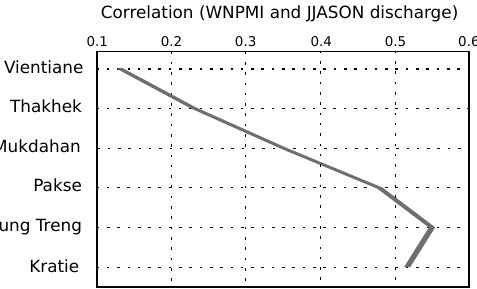
Fig. 6. The line shows the north-south evolution of the Pearson cor- relation between the JJASON average discharge and the WNPM